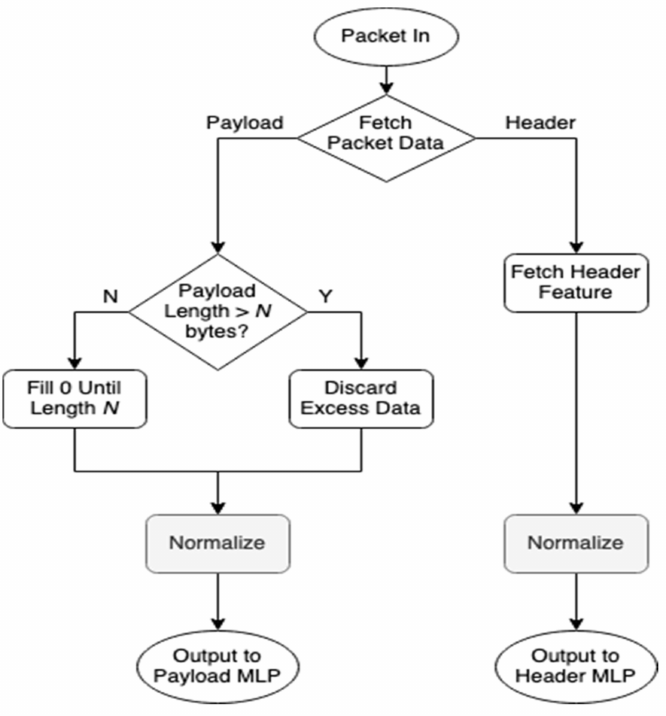
Figure 16. Data preprocessing